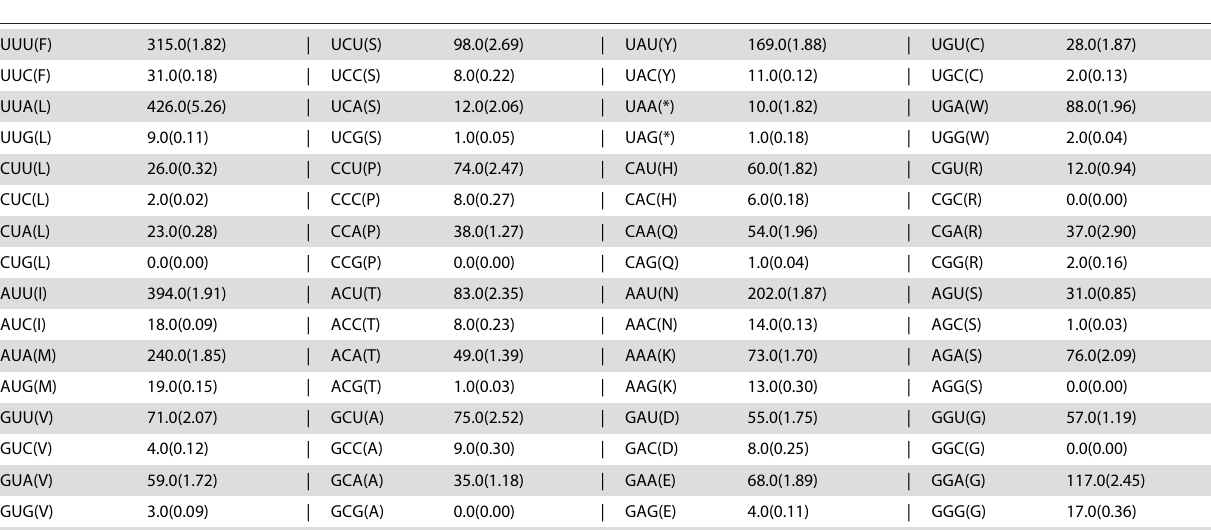
Table 3. Codon usage in the Maruca vitrata mitochondrial genome showing a high A-T nucleotide bias in the 3rd (wobble) position